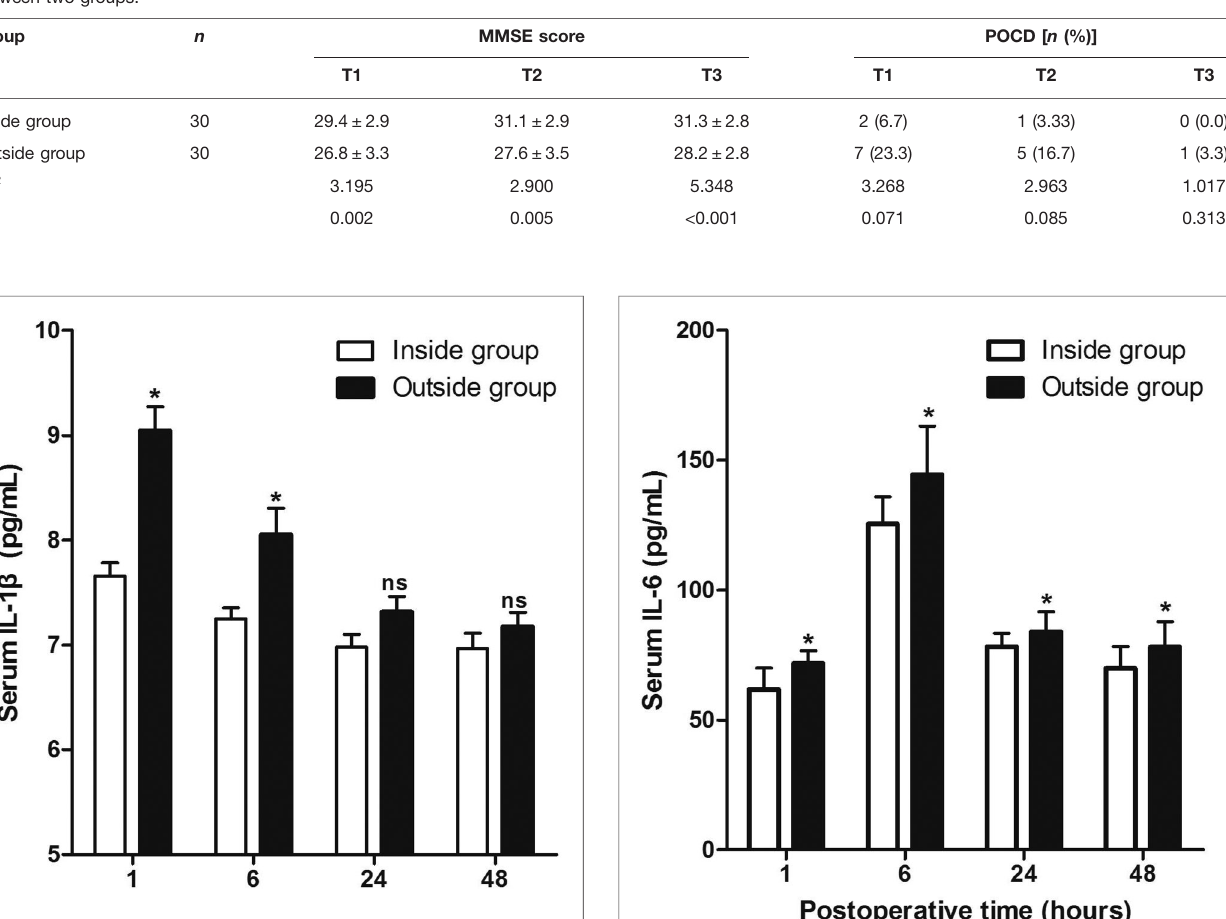
FIGURE 3 | Comparison of serum IL-1 β at different postoperative times between two groups. Compared with the Inside group, ns p >0.05 and * p <0.05. FIGURE 4 | Comparison of serum IL-6 at different postoperative times